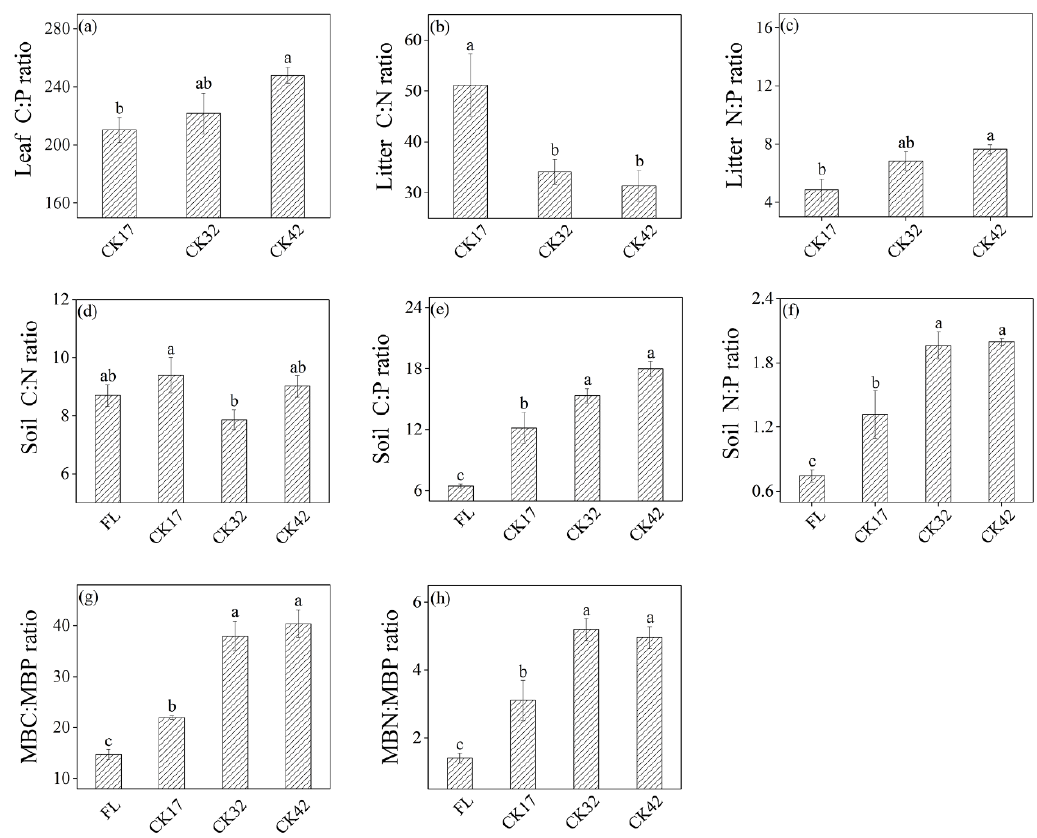
Figure 1. Changes of C, N, and P stoichiometry in leaf ( a ), litter ( b , c ), soil ( d – f ), and microbial biomass ( g , h ) among di ff erent stages of vegetation restoration. Error bars indicate the standard errors of the means. Means with di ff erent lowercase letters indicate significant di ff erences among di ff erent stages of vegetation restoration based on one-way ANOVA followed by an LSD test ( p <